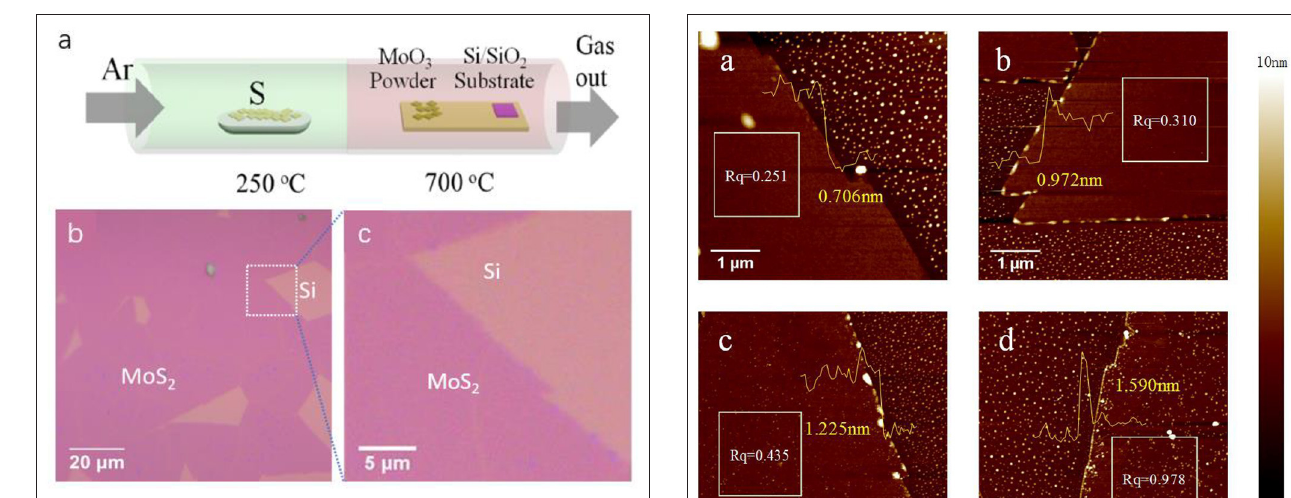
FIGURE 1 | (A) A schematic of the synthesis of a monolayer MoS 2 film using the chemical vapor deposition (CVD) method. (B,C) Optical micrographs of monolayer MoS 2 prepared by the CVD method on a silicon substrate. (B) Scale bar, 20 µ m. (C) Scale bar, 5 µ m. FIGURE 2 | Atomic force microscopy images of the monolayer MoS 2 film